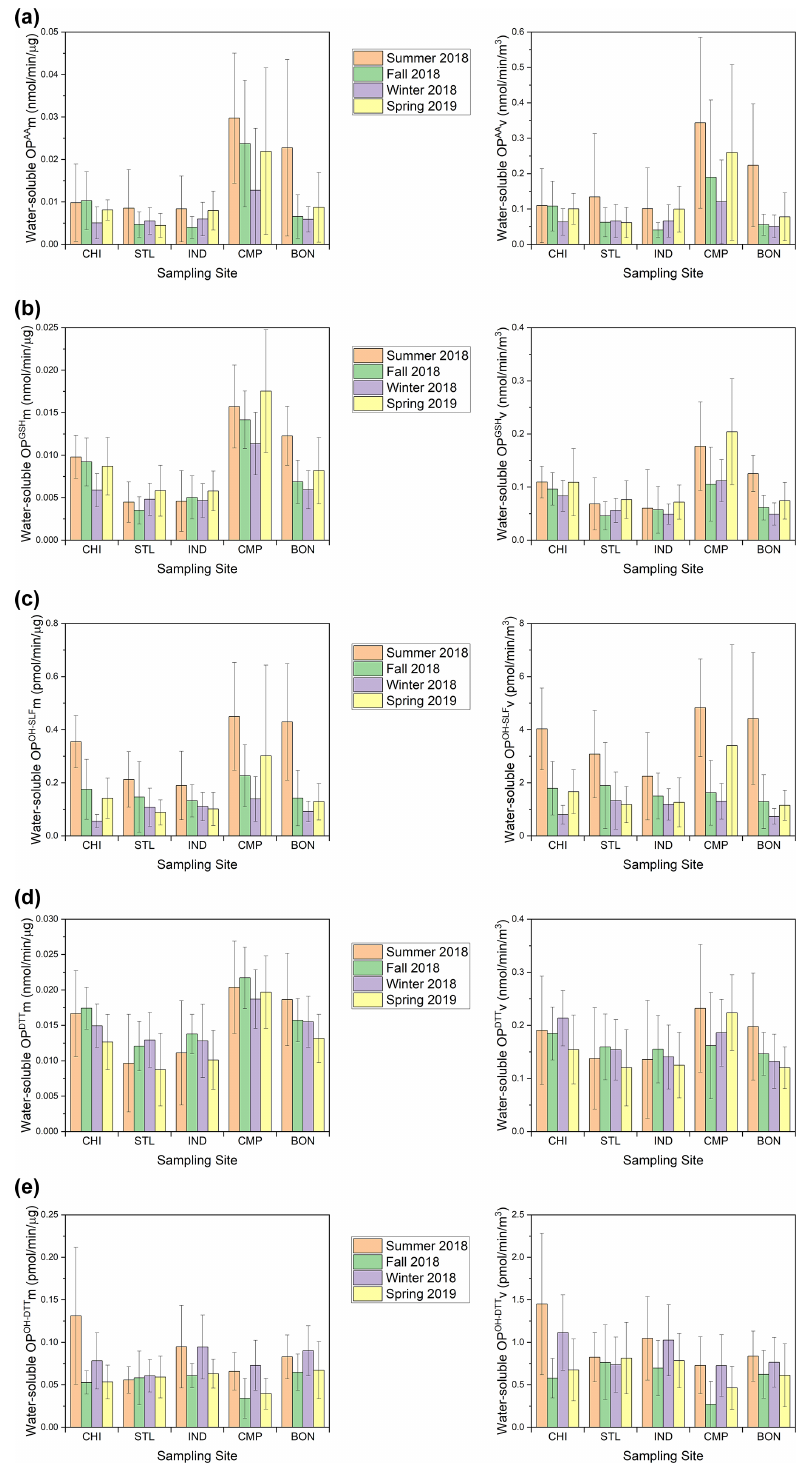
Figure 5. Seasonal averages of mass-normalized (left) and volume-normalized (right) water-soluble OP activities for (a) OP AA , (b) OP GSH , (c) OP OH − SLF , (d) OP DTT , and (e) OP OH − DTT at our sampling